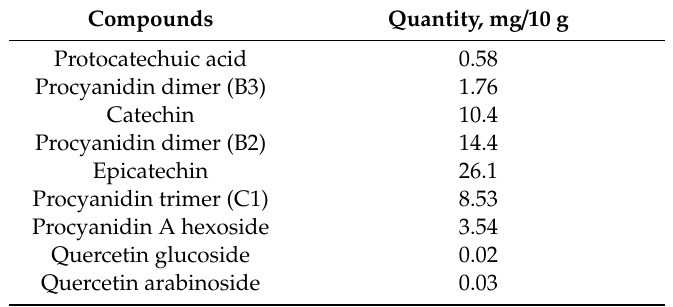
Table 1. Polyphenol composition of 10 g of 99% cocoa chocolate used in the